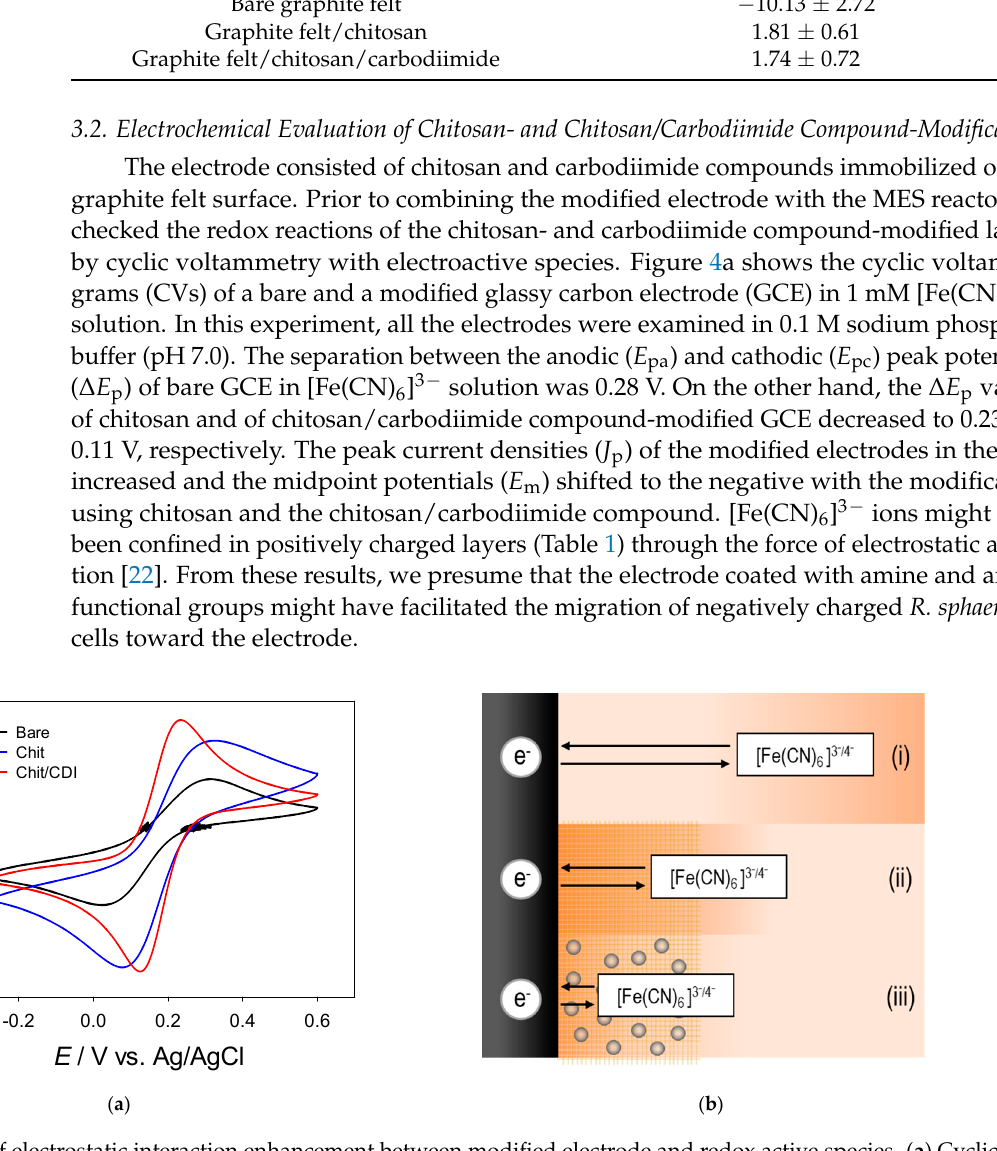
Figure 4. Evidence of electrostatic interaction enhancement between modified electrode and redox active species. ( a ) Cyclic voltammograms of bare and modified glassy carbon electrode (GCEs) in 0.1 M sodium phosphate buffer (pH 7.0) containing 1 mM of [Fe(CN) 6 ] 3 − . Scan rate, 20 mV s − 1 (versus Ag/AgCl). Bare indicates bare GCE. Chit indicates chitosan-modified GCE. Chit/CDI indicates chitosan/carbodiimide compound-modified GFE. ( b ) Schematic illustration of the redox reactions of diffusing and confined [Fe(CN) 6 ] 3 − ions in a chitosan layer. (i) Bare electrode, (ii) chitosan-modified (GFE/Chit), and (iii) chitosan/carbodiimide compound-modified